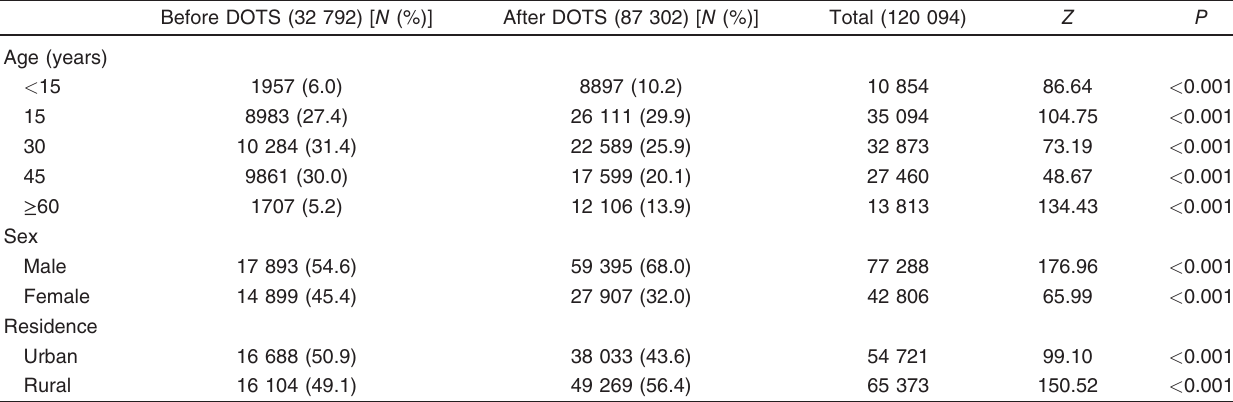
Table 5 Demographic criteria of cases of tuberculosis before and after application of directly observed treatment short-course strategy Before DOTS (32 792) [ N (%)] After DOTS (87 302) [ N (%)]